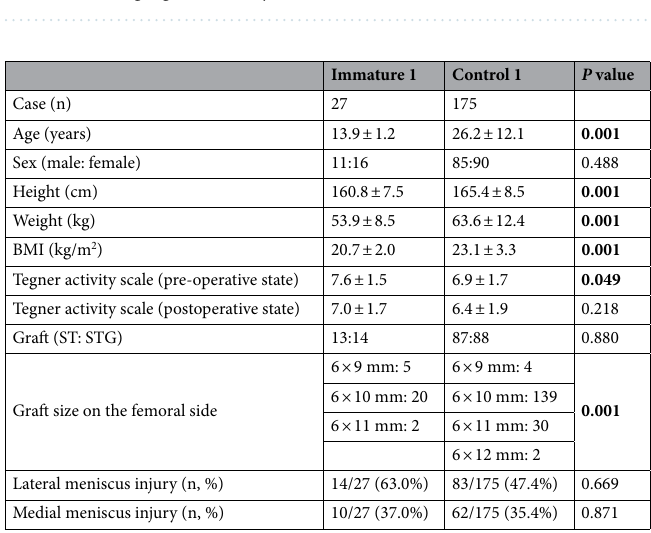
Figure 1. Study flowchart. ACLR anterior cruciate ligament, BTB bone-patellar tendon-bone, MRI magnetic resonance imaging, BMI body mass index.